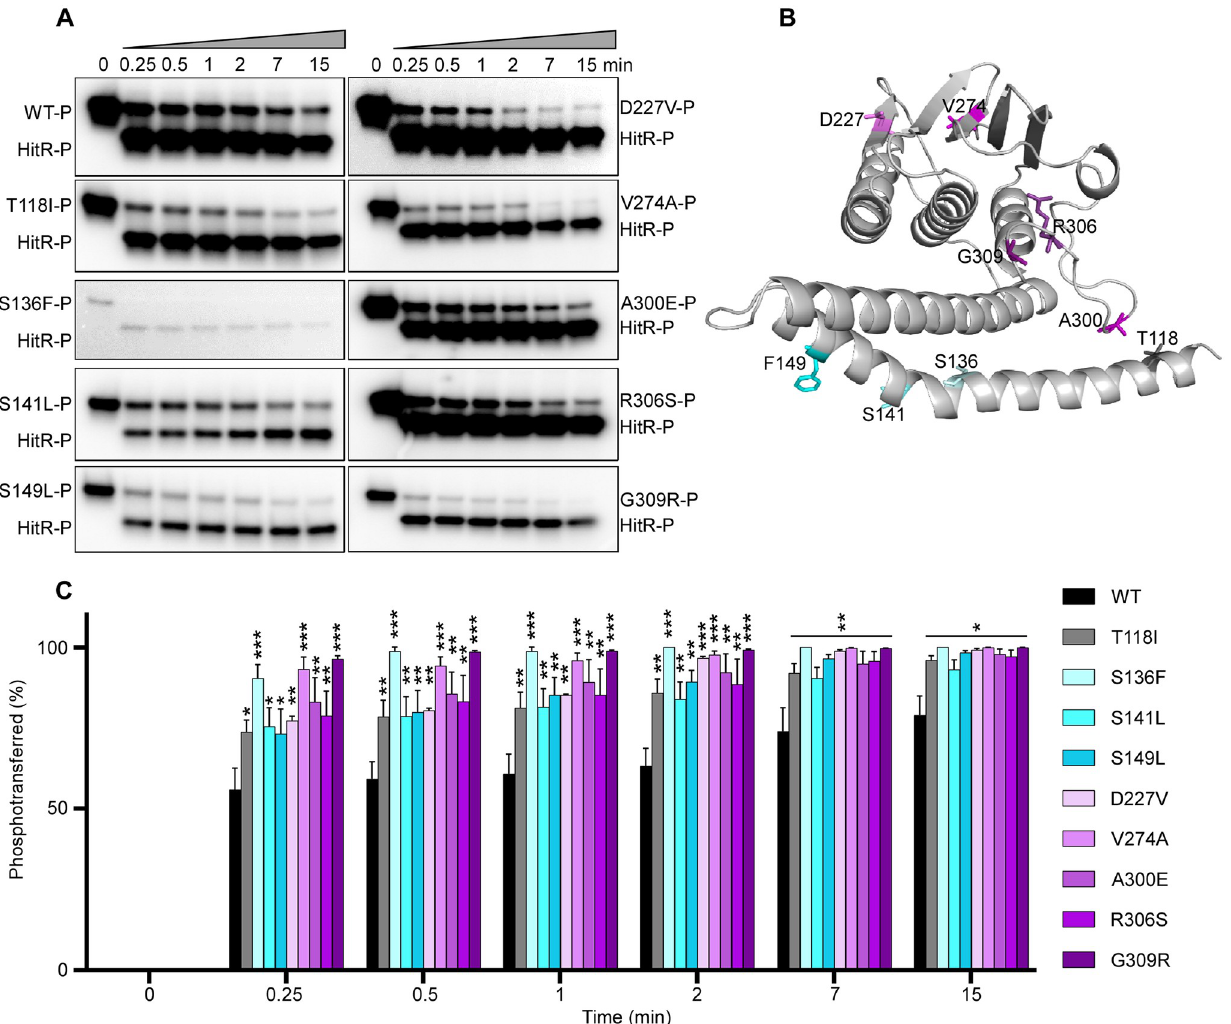
Fig 5. Phosphotransfer is the rate limiting step for signal transduction. To evaluate the effects of HitS ON mutations on transferring the phosphorylation signal, phosphotransfer efficiency of HitS WT or ON mutants to HitR WT was examined. (A) Representative phosphor images to show the kinetics of phosphotransfer from HitS WT or ON mutants to HitR WT, which was monitored for 15 min. (B) Mutations tested are mapped onto the HitS model. (C) The intensity of the lower band (signal transferred) was quantified and relative phospho-signal transferred at different time-points was calculated. Data shown in (C) are from three independent replicates (mean ± SEM). Significant differences determined by two-tailed t-test were observed between WT and each individual activating mutant, where � P < 0.05, �� P < 0.01, and ��� P <